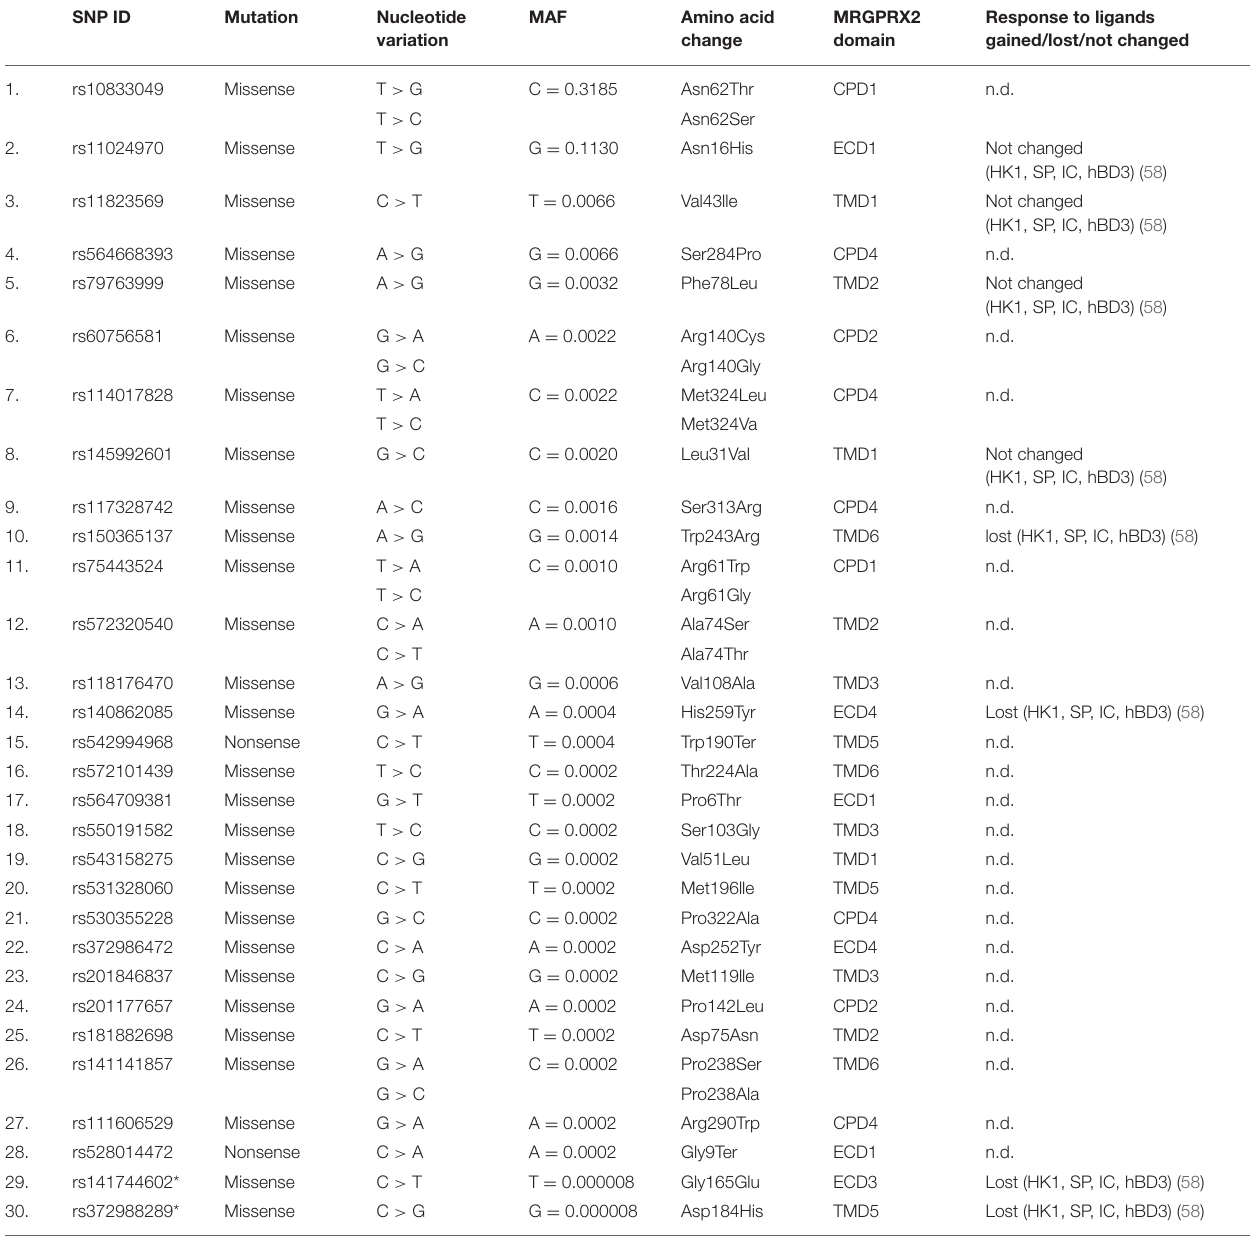
TABLE 1 | The list of SNPs within coding regions of the human MRGPRX2